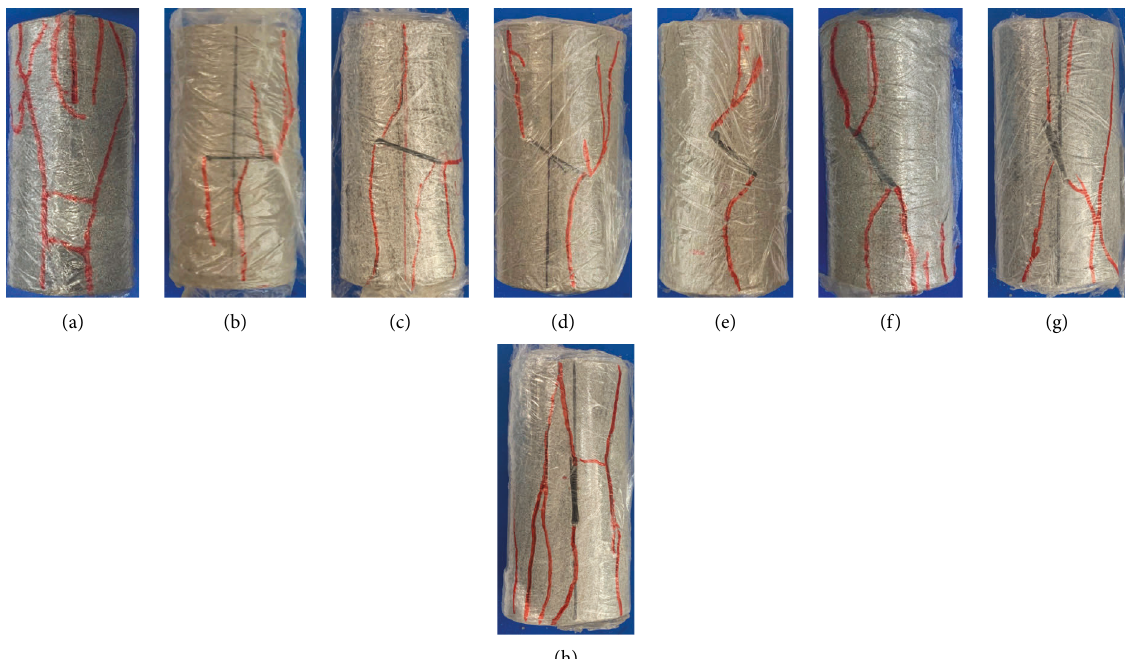
Figure 8: Destruction mode of fissured sandstones with different dip angles. (a) A-intact. (b) A-0. (c) A-15. (d) A-30. (e) A-45. (f) A-60. (g) A-75. (h)